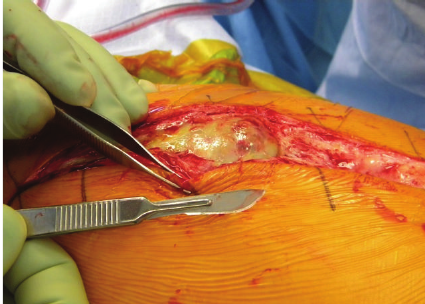
Figure 3: Revision surgery.